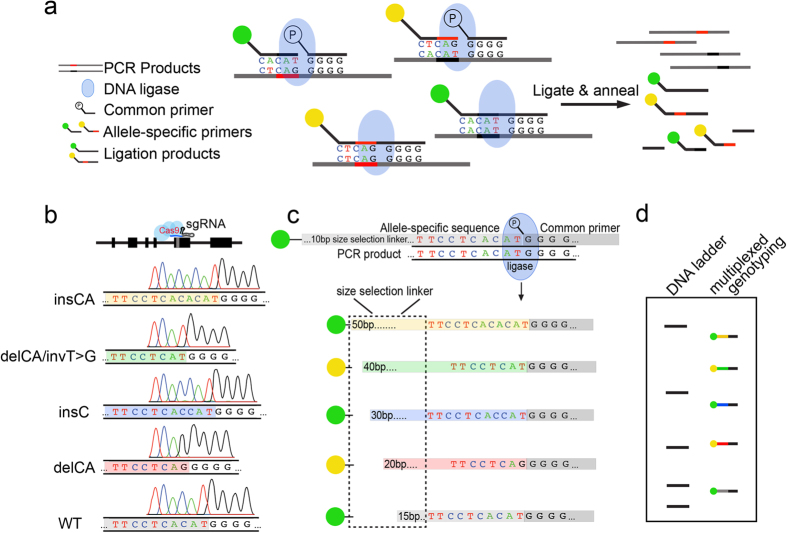
LDR genotyping strategy to detect small in-dels in Asxl3.(a) LDR utilizes DNA ligase to ligate together perfectly adjacent primers. Allele-specific primers are designed to complement a common primer that recognizes all alleles similarly. Ligation products are created only when the allele-specific and common primers completely anneal to PCR products amplified from organism to be genotyped. (b) Asxl3 mouse alleles created with CRISPR/Cas9 genome editing. Cas9 nuclease (light sky blue) was targeted to Asxl3 Exon 12 by a single guide RNA (sgRNA). Target specific double strand DNA cleavage was repaired by non-homologous end joining creating in-dels [CA deletion and T > G transversion (del1), C insertion (ins1), CA deletion (del2), and CA insertion (ins2)] defined by Sanger sequencing. (c) Allele-specific and a common primer pair are designed to distinguish specific alleles within each PCR amplicon. The allele-specific and common primers are ligated on complementary amplicons by thermostable ligase (skyblue). Each allele-specific primer is designed with a 5′ size-selection linker of varying nucleotides to modulate the lengths of ligation products and fluorescently labeled FAM- (yellow circle) or TET-tag (green circle). The common primer is phosphorylated at the 5′ end. (d) Products of LDR reaction can be separated on an acrylamide gel and uniquely detected based on size and fluorophore.